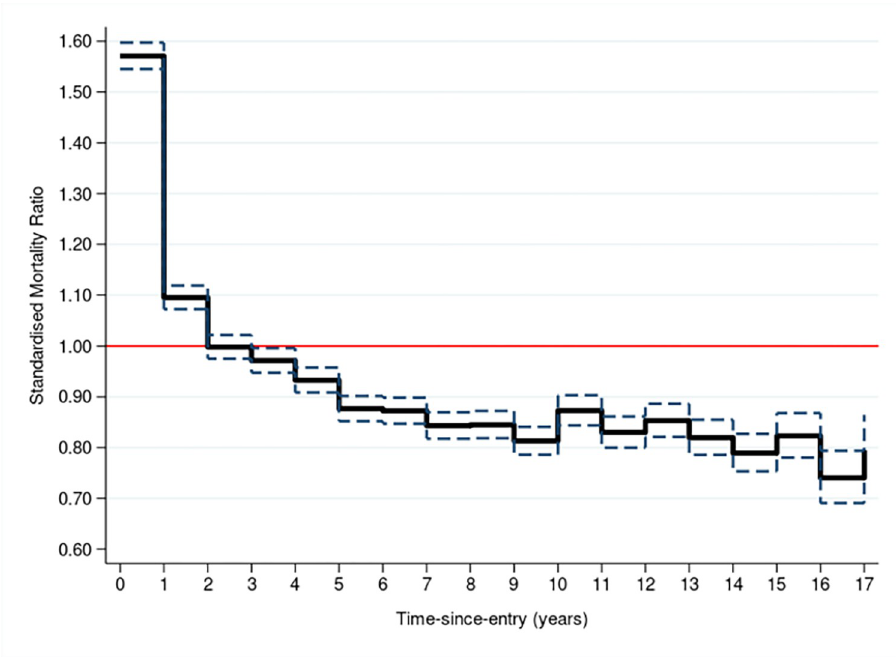
Fig 4. Standardised mortality ratio (SMR) and 95% confidence interval by follow-up time-since-entry, in years. Reference line of SMR = 1 in red.